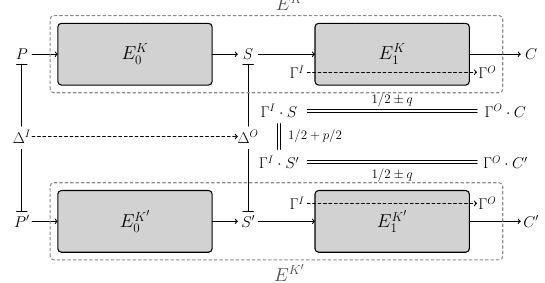
Figure 2: Related-key differential-linear